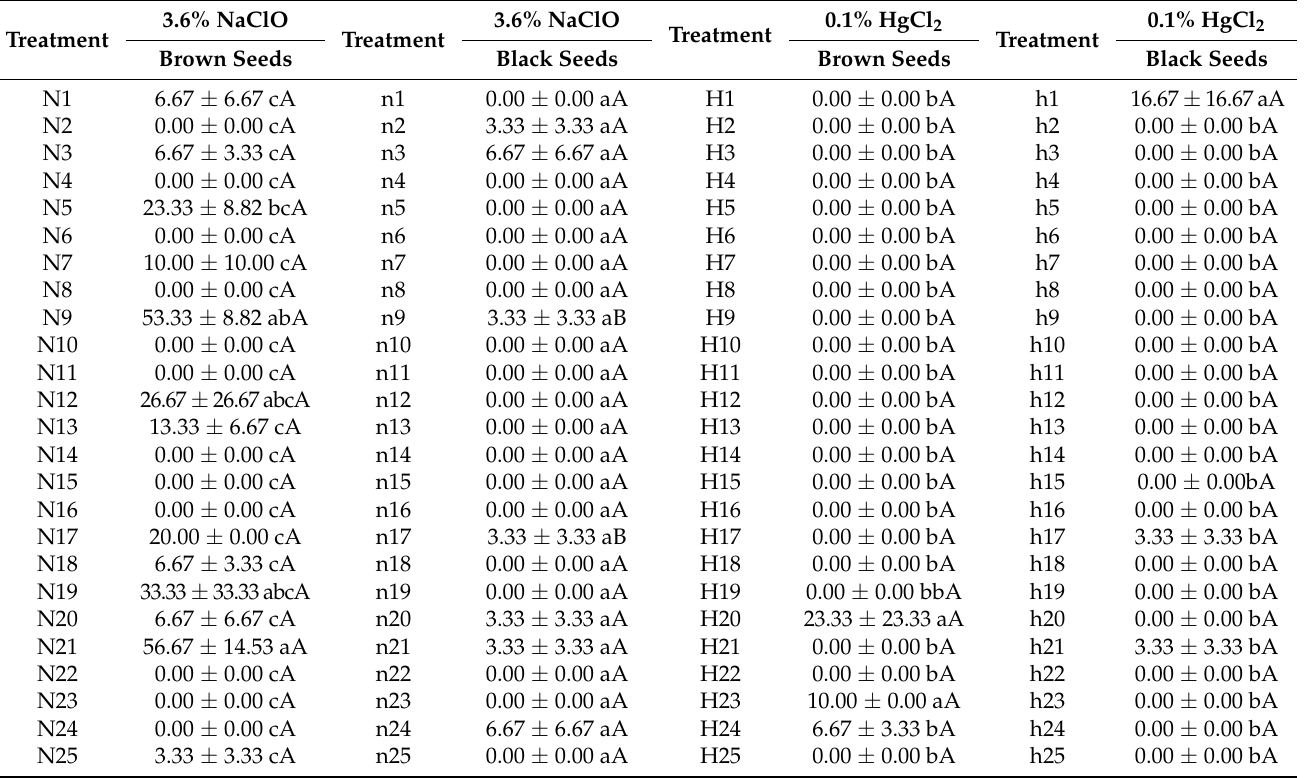
Table 5. Contamination percentage of Suaeda aralocaspica seeds cultured with different treatments after 20 days